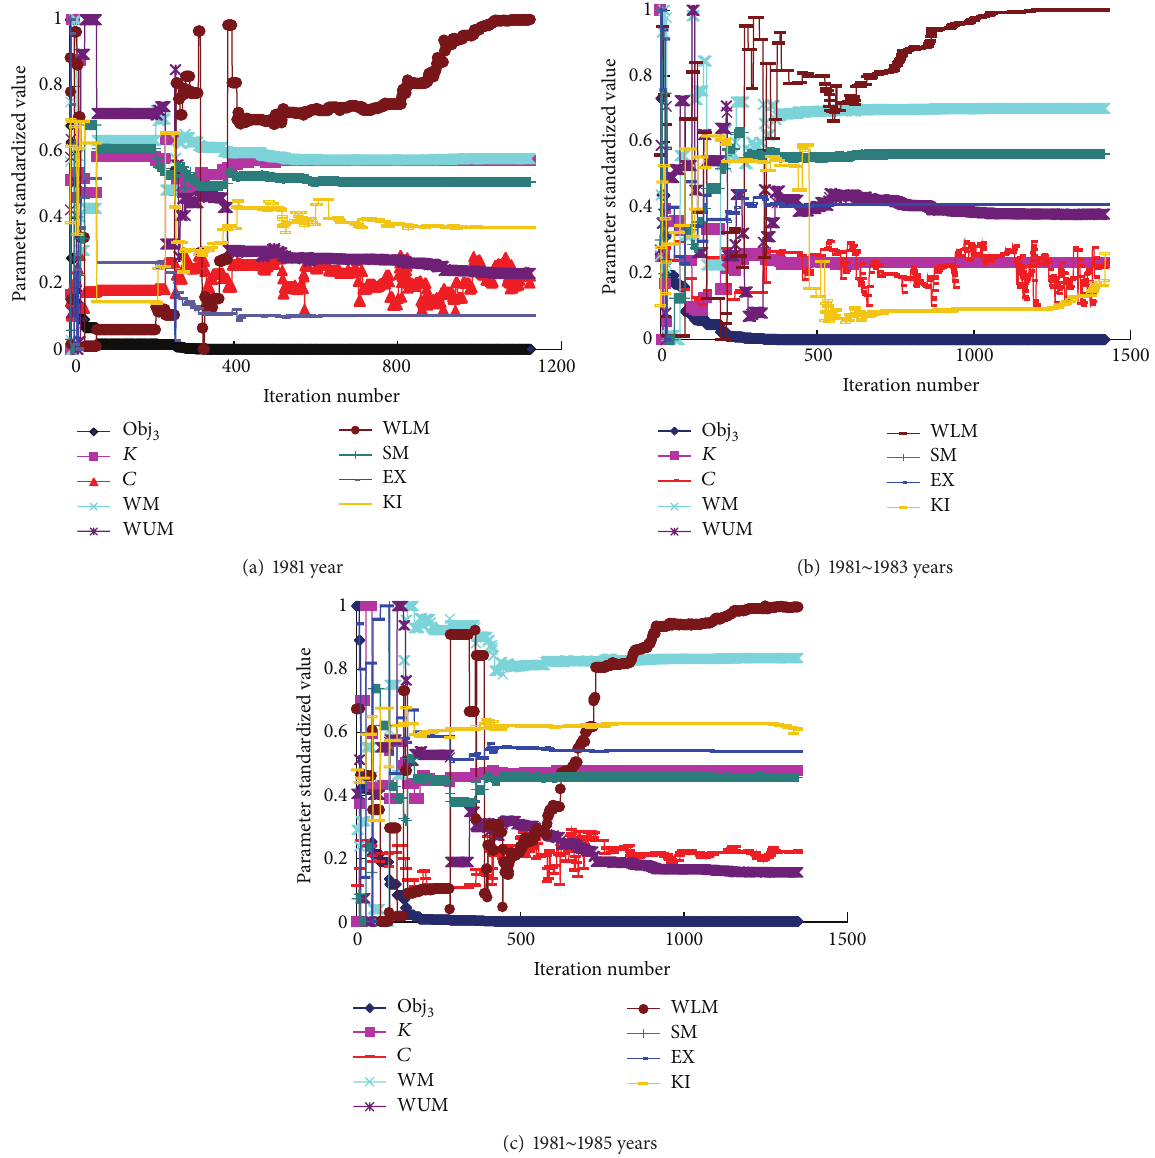
Figure 2: Convergence of the optimization using ideal